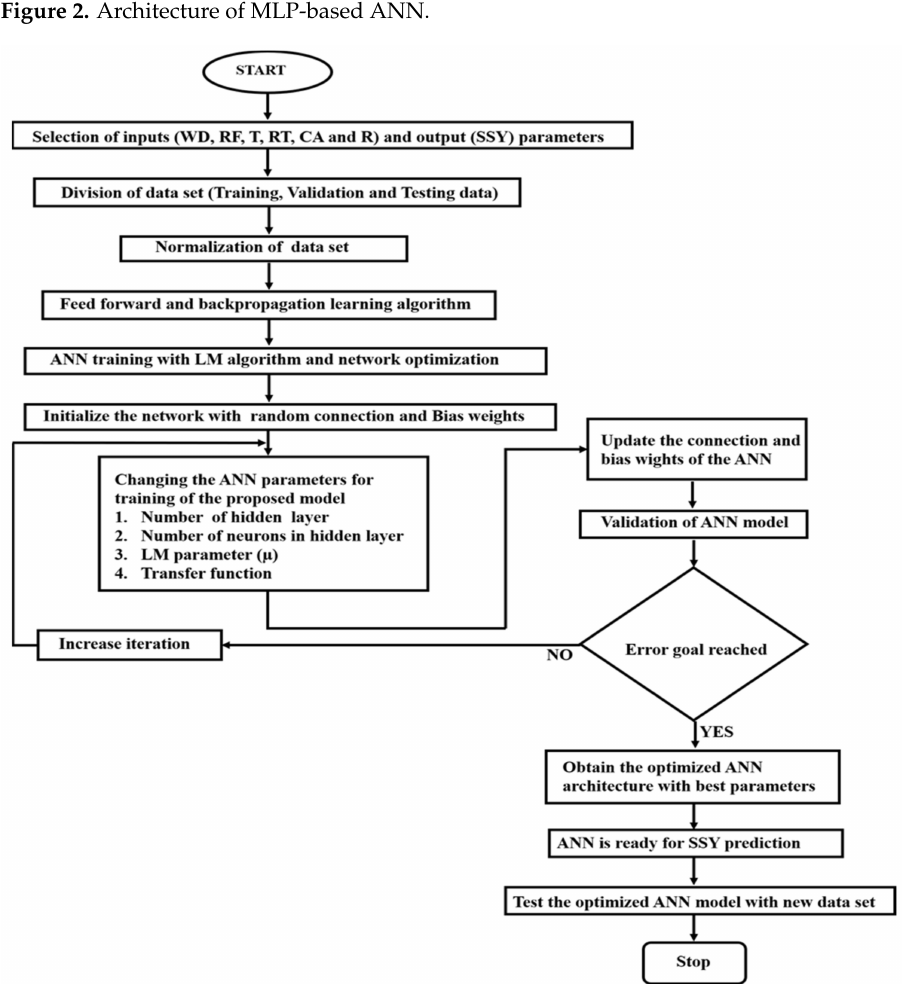
Figure 3. The flowchart of the proposed ANN model with heuristic parameters selection processes for SSY